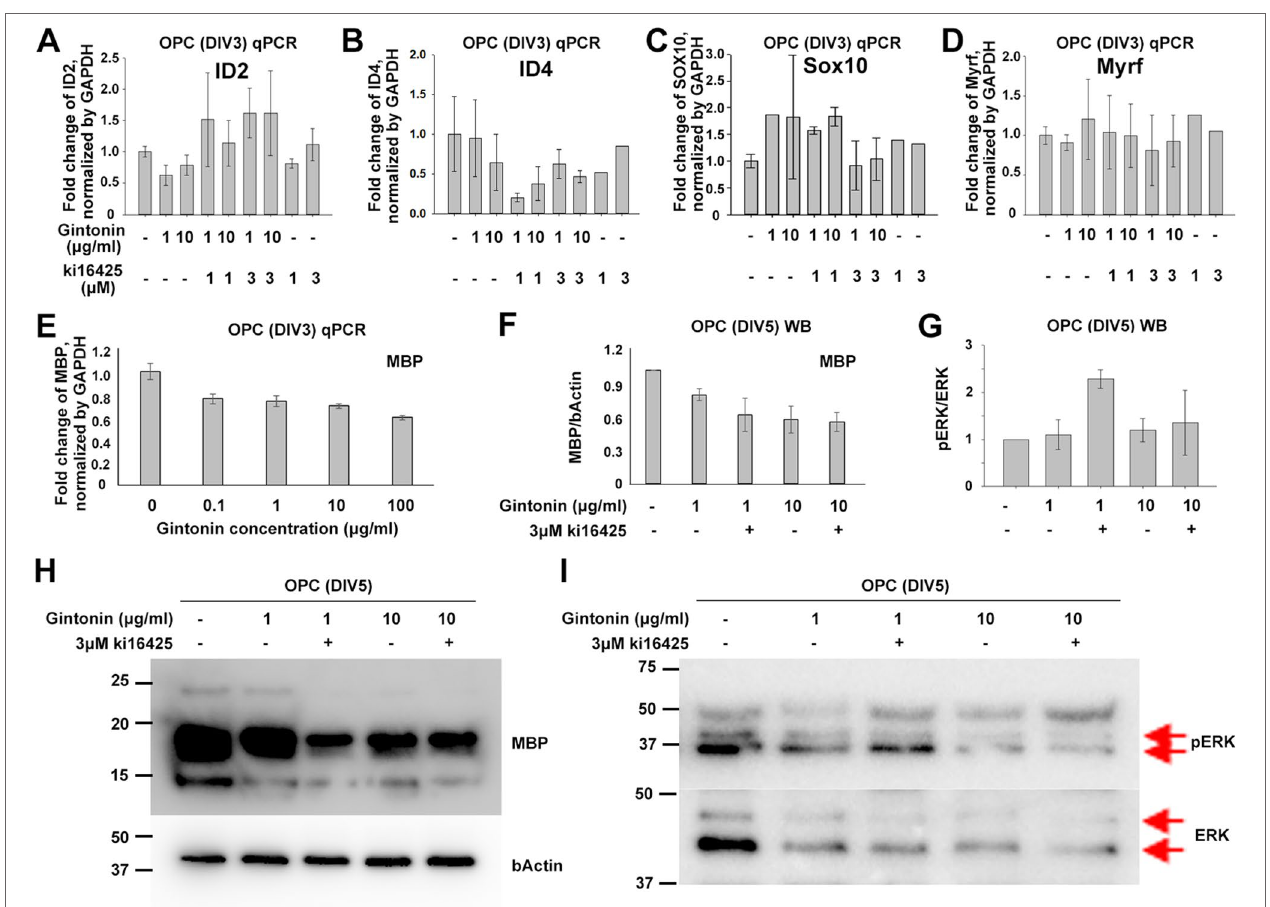
FIGURE 3 | Gintonin does not change the expression of transcription factors at early stage of oligodendrocyte development. For differentiation analysis, isolated OPC s were treated with gintonin or Ki16425 or both of them as indicated during DIV1–3 (A – E) or DIV1–5 (F – I) . Medium was changed every two days. (A – E) At DIV3, RNA expression of inhibitory (A , B) , facilitatory (C , D) transcription factors of oligodendrocyte differentiation and myelin gene expression (E) were investigated on OPC cultures by real-time PCR. (F – I) At DIV5, protein expression levels of MBP (F , H) and phospho ERK (pERK) (G , I) were investigated on OPC cultures by Western blot. Protein bands of ERK and pERK are indicated by red arrows (I) . No significant changes were found by gintonin treatment in the real-time PCR or Western blot analysis. Bars represent mean ±